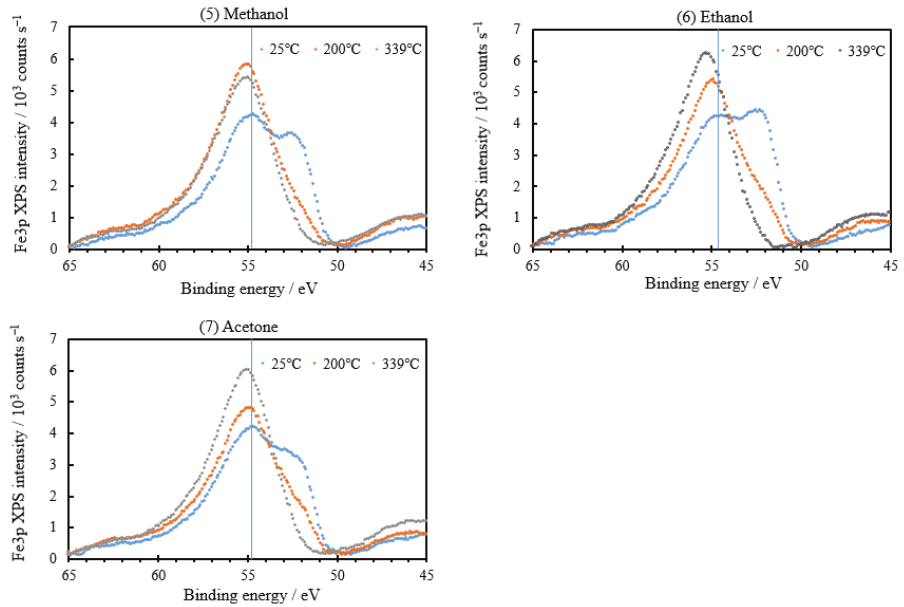
Figure 2. Temperature dependence of Fe 3 p spectra of real iron surfaces scratched in different environments: air, (2) benzene, (3) cyclohexane, (4) water, (5) methanol, (6) ethanol, and (7) acetone.